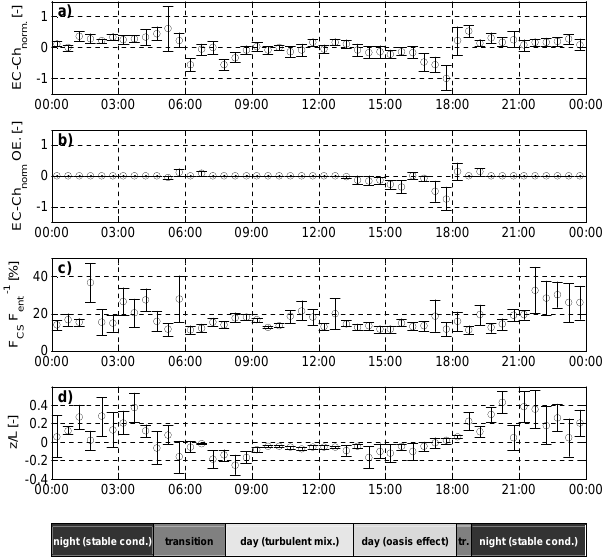
night (stable cond.) transition day (turbulent mix.) day (oasis effect) tr.